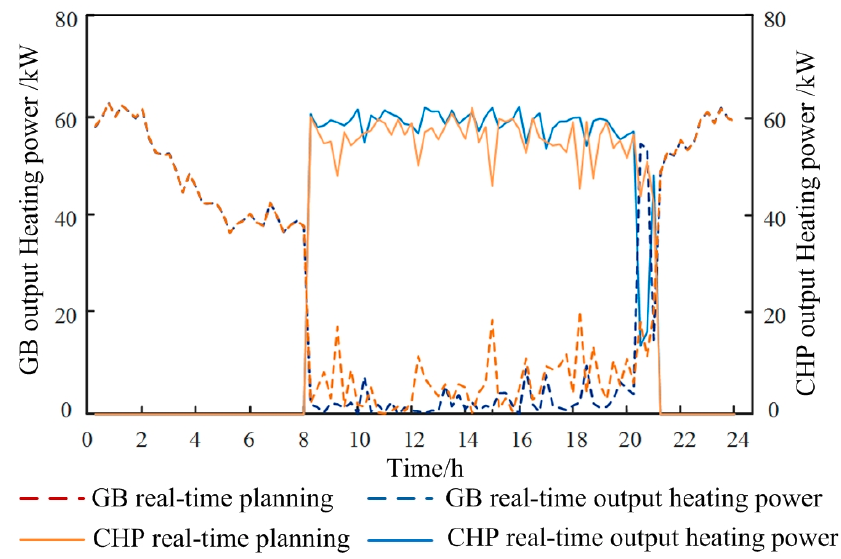
Figure 7. Comparison of real-time planning and actual output of thermal power output of gas-fired boilers and CHP.